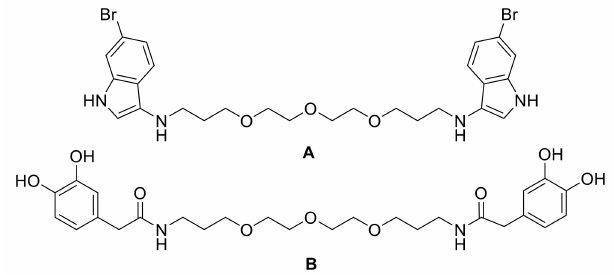
Figure 1. Biologically active N,N (cid:48) -disubstituted trioxadiamines: antimicrobial activity ( A ), antiprotozoal activity ( B